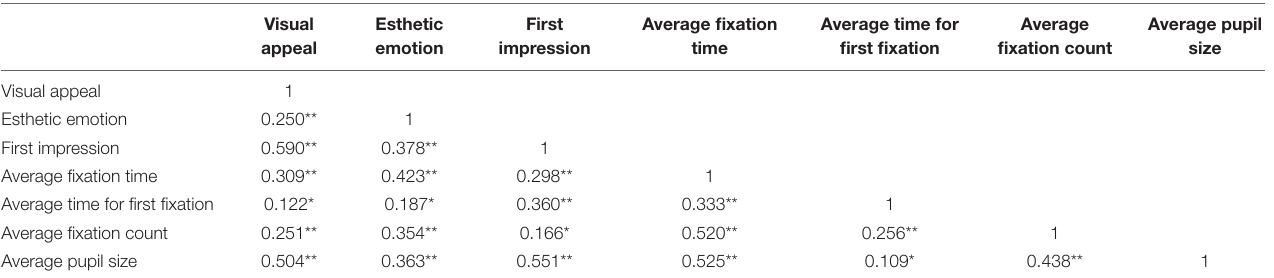
FIGURE 4 | Saccadic length. TABLE 4 | A correlation analysis.